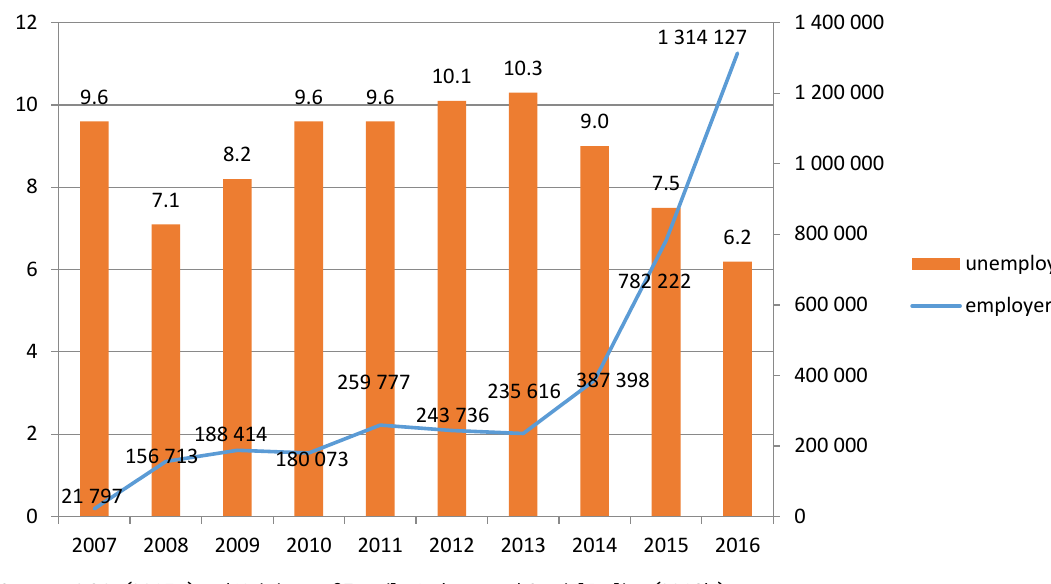
Source: CSO (2017a) and Ministry of Family, Labour and Social Policy